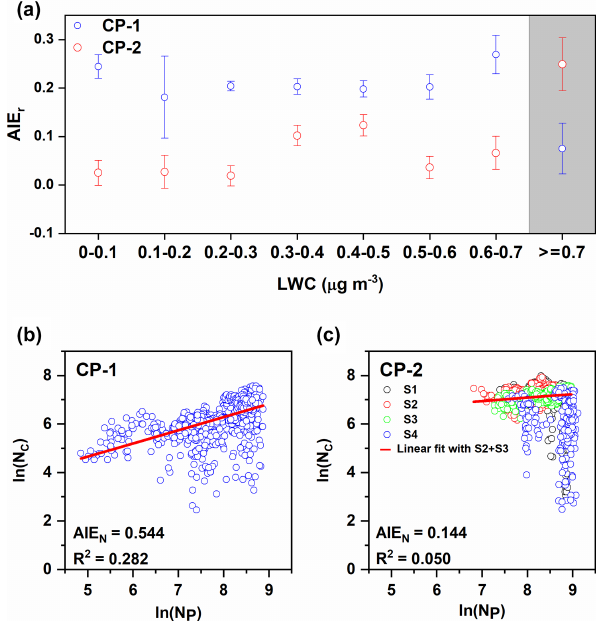
Figure 4. (a) The determination of AIE r for each LWC bin with 0.1gm − 3 . The determination of AIE N based on N C (b) during CP- 1 and (c) during